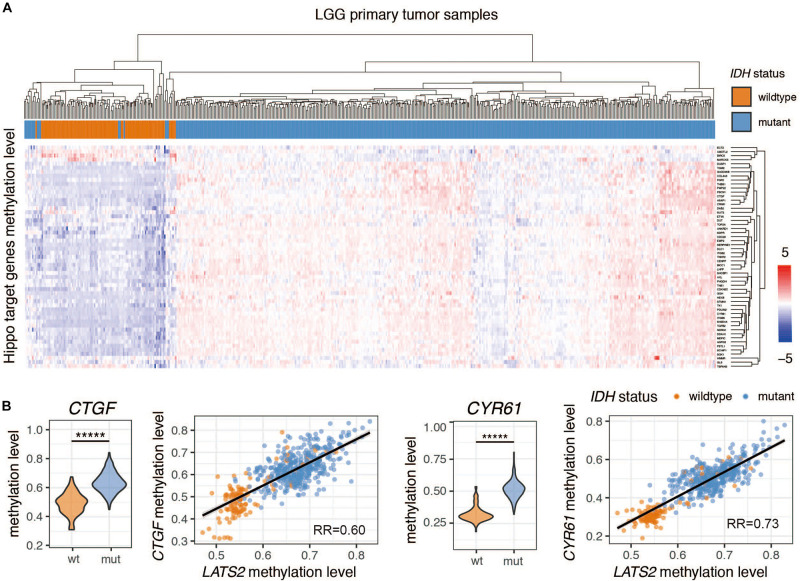
Hippo pathway target genes are universally hypermethylated in IDH-mutant LGG. (A) cluster analysis of Hippo target gene methylation levels in IDH-wildtype and mutant LGG. The Normalized beta value is scaled across each gene to yield standard score (Z-score) (B) Methylation levels of Hippo target genes CTGF and CYR61 are significantly increased in IDH-mutant LGG. Correlation between CTGF/CYR61 methylation level and LATS2 methylation level is shown. Compared by t test (*****p < 0.000005, t test).